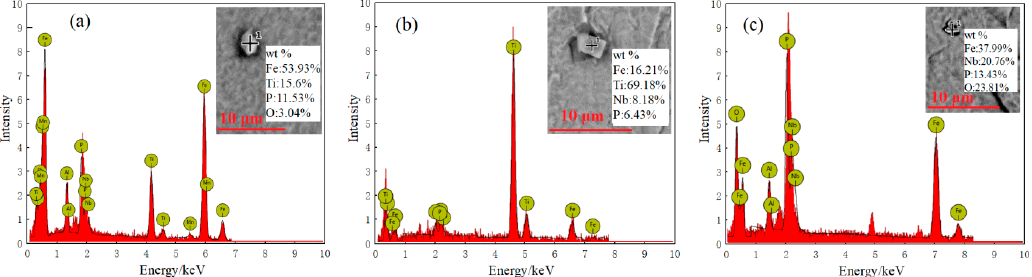
Figure 8. The Fe(Nb+Ti)P precipitation of sample 1# detected in the rolling process: ( a ) HR, ( b ) CR, ( c ) CA.